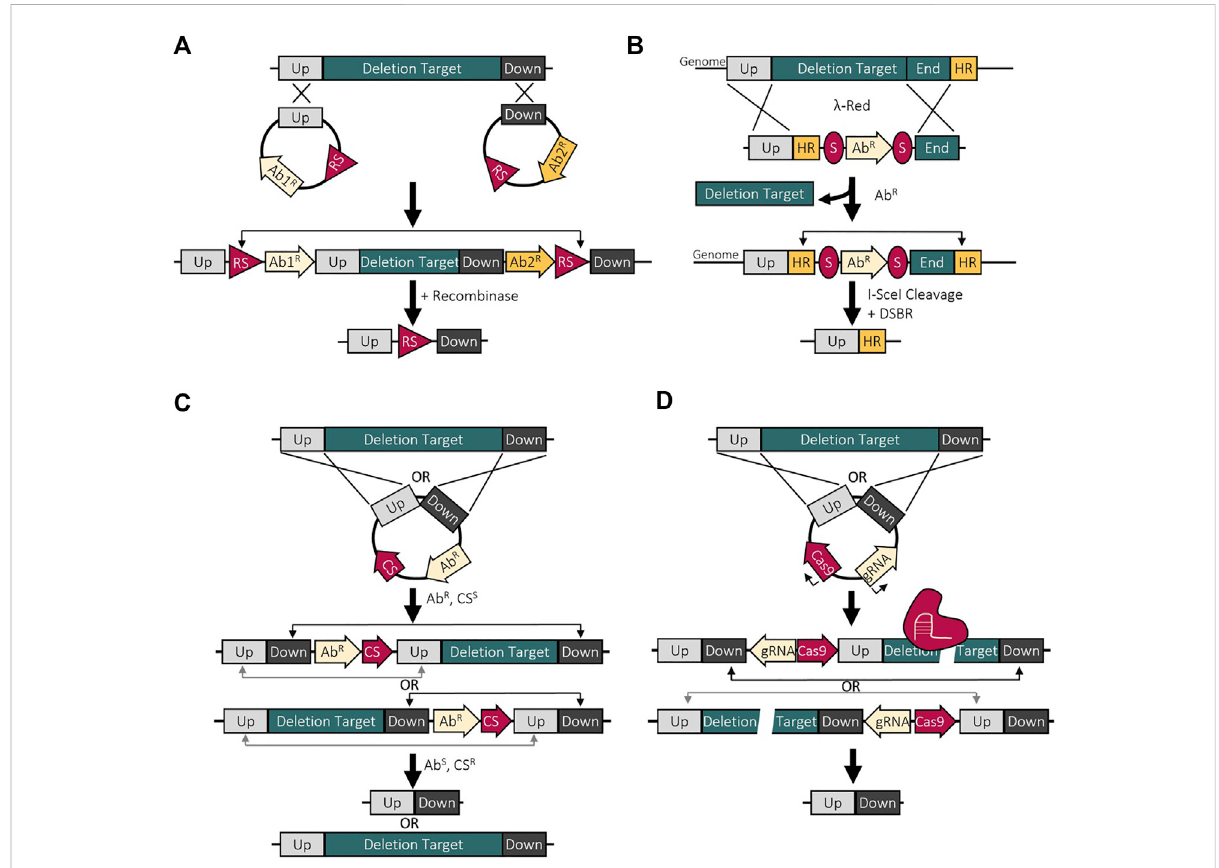
FIGURE 3 Deletionmethodsusedtomakelargegenomicreductions. (A) Site-speci fi crecombinationdeletionmethodusingtworecombinationsites(RS) which are acted on by a recombinase to result in recombination and deletion of the target. (B) λ red recombineering with I-SceI uses a linear DNA fragmentwithI-SceIcutsites(S)tocauseadouble-strandedbreakwithrecombinationbetweenthehomologousregions(HR)torepair,resultingina deletion. (C) Homologous recombination mediated deletions using a counterselectable marker (CS) to select for the second recombination eventresultinginthedeletion orreturn ofwild-type. (D) CRISPR-baseddeletions employing Cas9to causeadouble-strandedbreak,forcing thecell to repair using homologous recombination, resulting in the